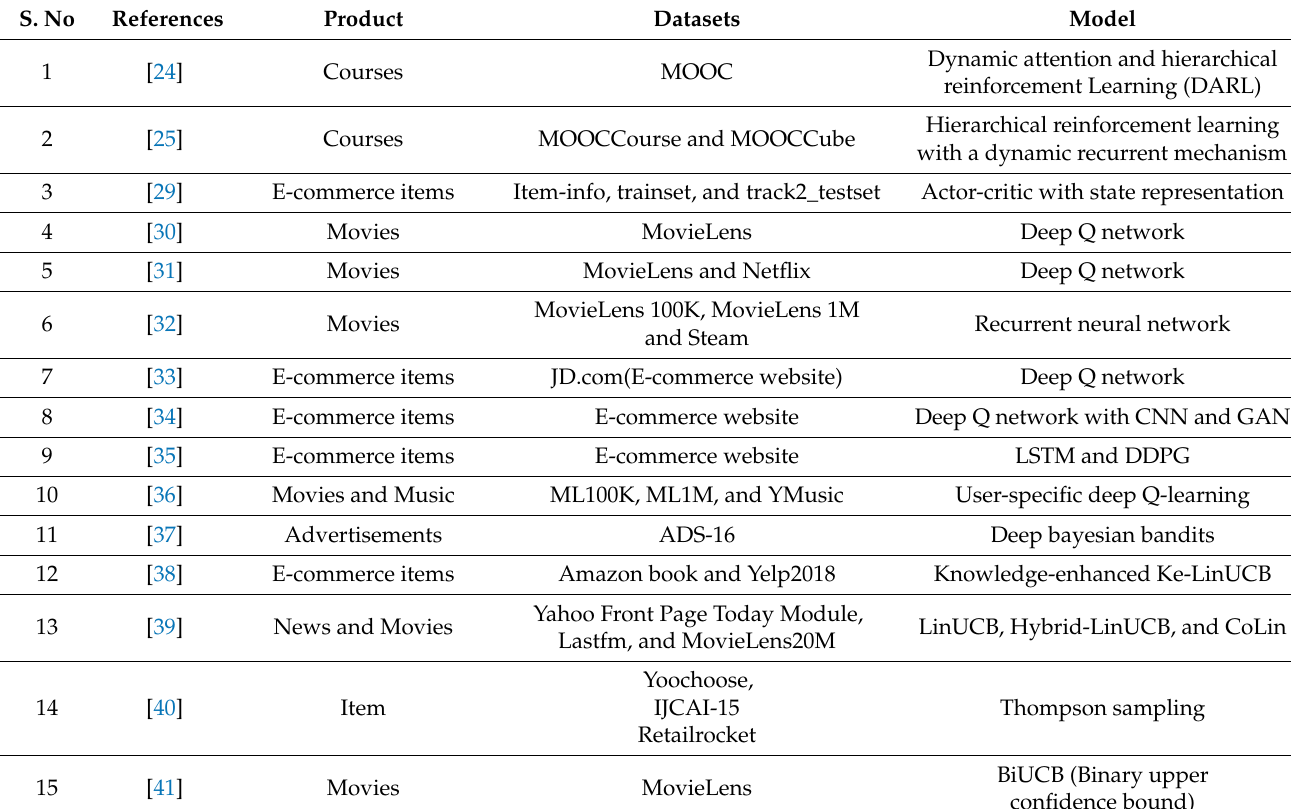
Table 1. Reinforcement learning applications for recommendation